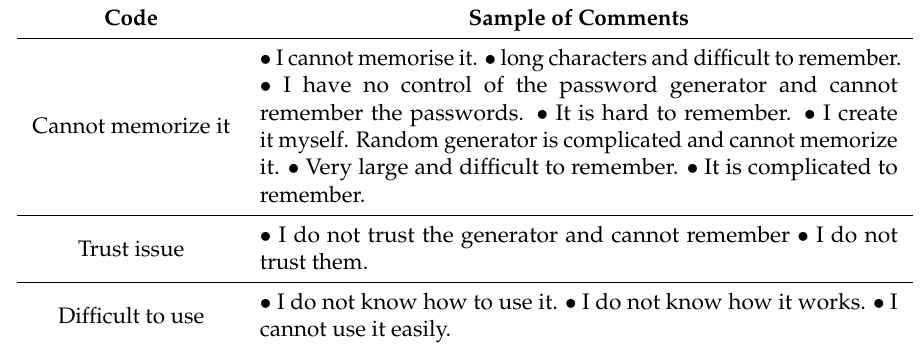
Table 14. Comments sample for the question “Have you ever used a random password